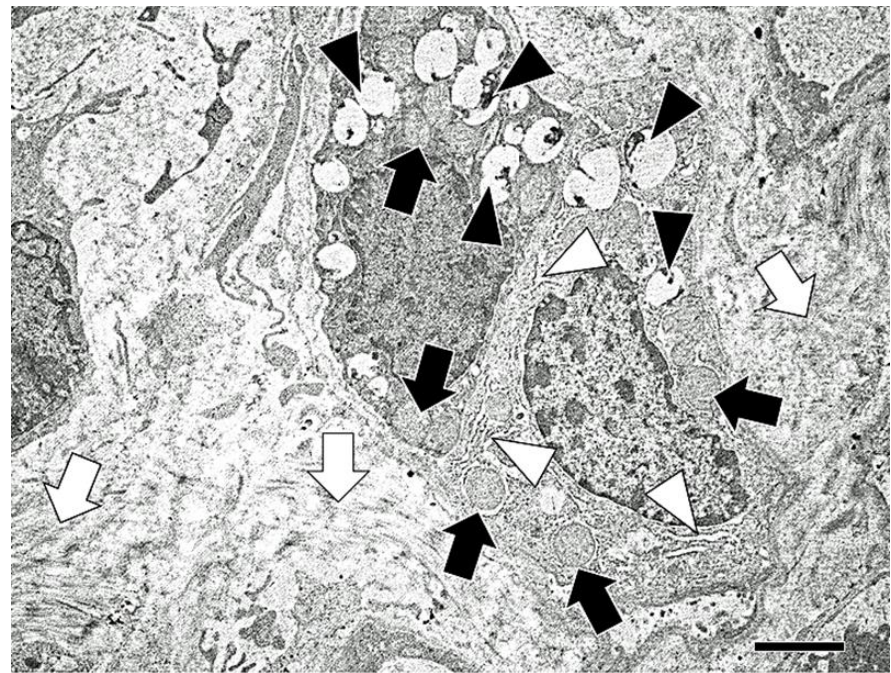
Figure 9. Electron microscopy of the lung tissues at 12 months after silica treatment. Elongated cells, which have features of alveolar type II epithelial cells (lamellar bodies) (white arrow heads) contain abundant rough endoplasmic reticulum (black arrow heads) and mitochondria (black arrows), are shown in the fibrotic lesions with increased collagen bundles (white arrows). Note no desmosome structures between the two cells. Bar = 5 μm.